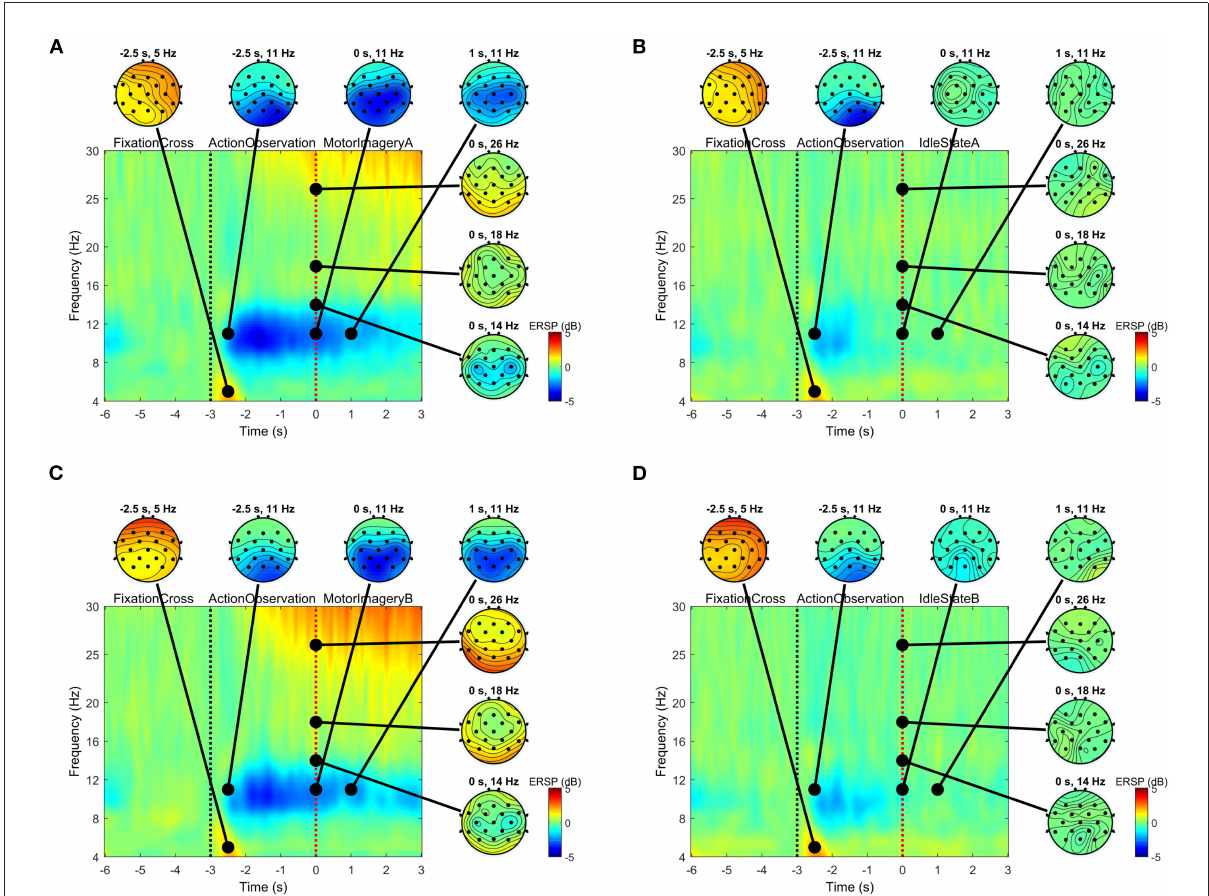
FIGURE5 Group-level event-related spectral perturbation (ERSP) for frequencies between 4 and 30 Hz across all trials pooled for sit-to-stand (top panels) and stand-to-sit (bottom panels) experiments compared to the baseline from − 3.5 to − 3 s. Time-frequency (TF) plots combined the TF decompositions across all channels. Note that these plots with the 2-D scalp topographies also combined ERSP from different subjects and all present ERSP values were statistically significant compared to the baseline ( α = 0.05). The time interval ( − 6, − 3] s corresponds to the fixation stage, ( − 3,0) s corresponds to the action observation stage, and [0,3) s corresponds to the stage of one of the four experimental tasks: (A) MotorImageryA, (B) IdleStateA, (C) MotorImageryB, or (D)